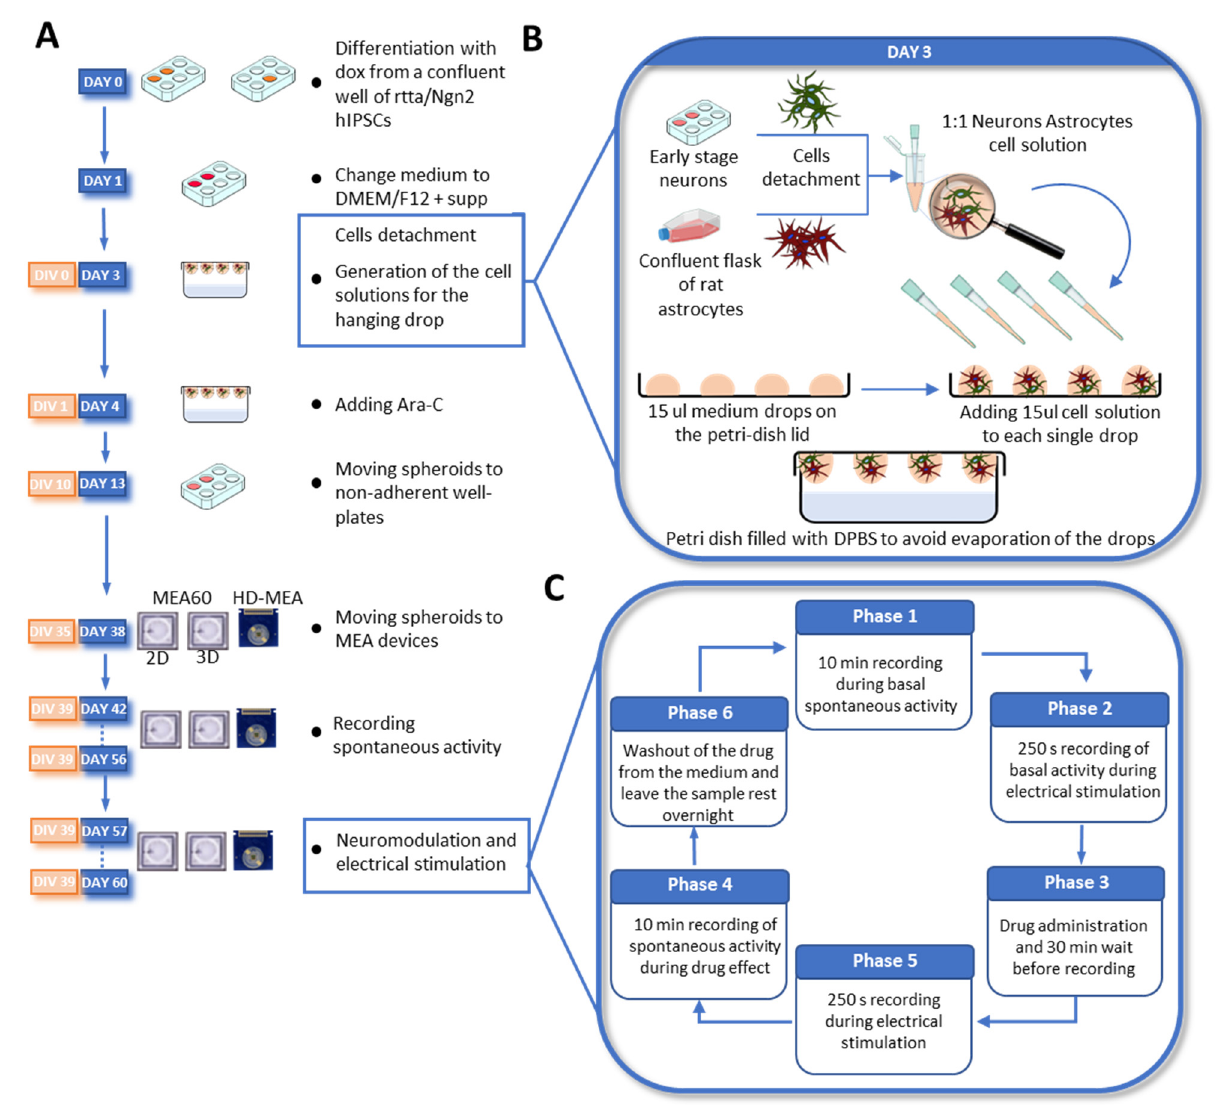
Figure 1. Overview of the differentiation steps and experimental design. ( A ) Timeline of the devel- opment of the neurospheroids from the differentiation process to the transfer and growth onto the MEAs. ( B ) Main steps performed at DAY 3/DIV 0: Collection of cells and hanging-drop technique. Early-stage neurons and astrocytes are harvested the same day in two separate tubes. Consequently, cells are counted and mixed in a 1:1 ratio in a 1 mL vial at a final concentration of 5,330,000 cell/mL. Therefore, 15 µL of the cell suspension were plated on 15 µL medium drops in the lid of a petri dish. Finally, the lid was gently placed back on the petri dish, half- fi lled with DPBS, and then stored in the incubator. ( C ) Experimental protocol for chemical neuromodulation and electrical stimulation.